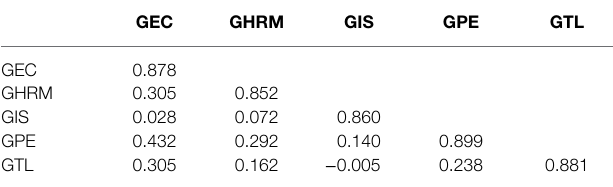
TABLE 5 | Discriminant validity.